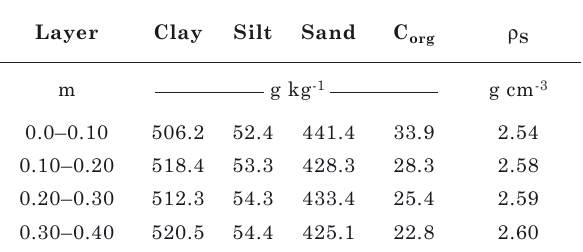
Table 1. particle size, organic carbon and particle density in the different evaluated layers of a rhodic hapludox before